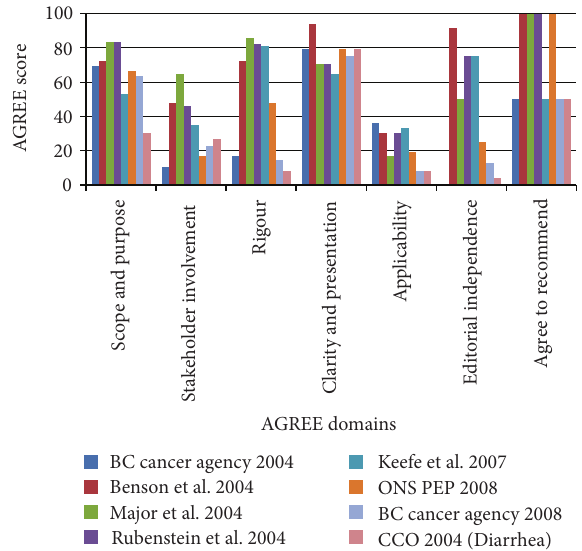
Figure 2: Diarrhea guideline AGREE scores for each of the AGREE domains with higher scores indicating higher quality guidelines ( 𝑛 = 8 guidelines).